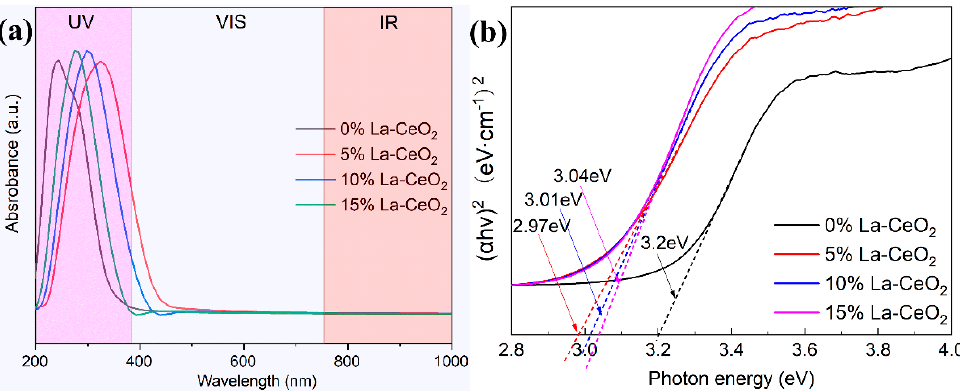
Figure 6. ( a ) Calculated optical adsorption spectra of cerium oxide doped with different lanthanum concentrations (0%, 5%, 10%, and 15%); ( b ) forbidden band width of above four samples.